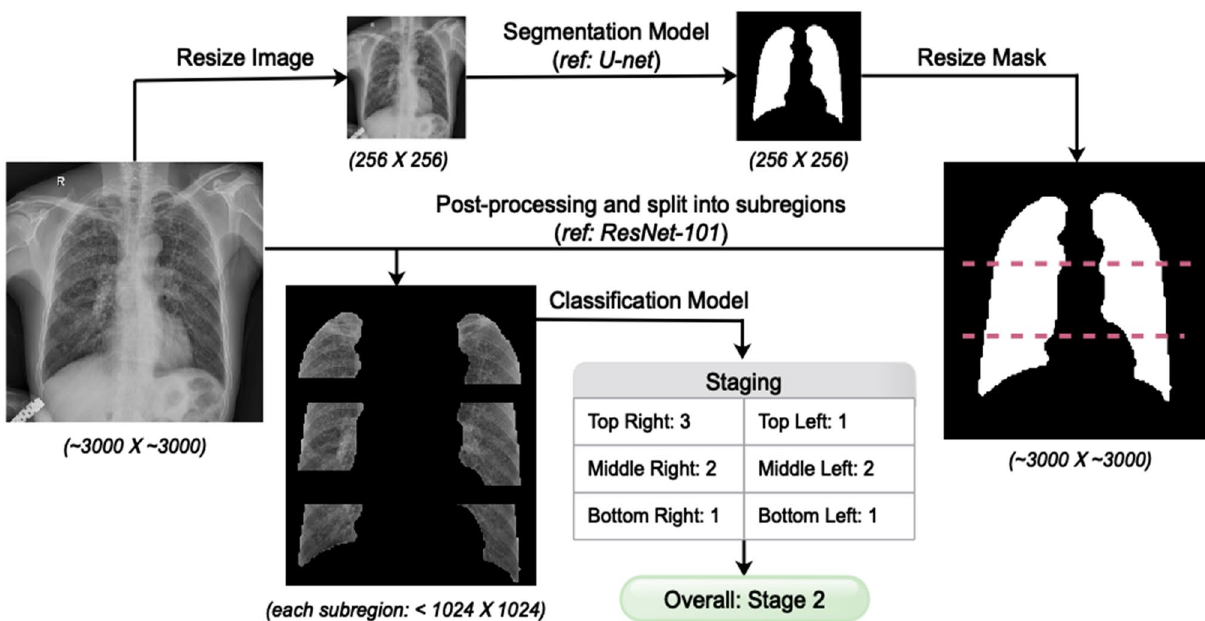
Figure 2. A novel two-stage deep learning model for pneumoconiosis screening and staging.